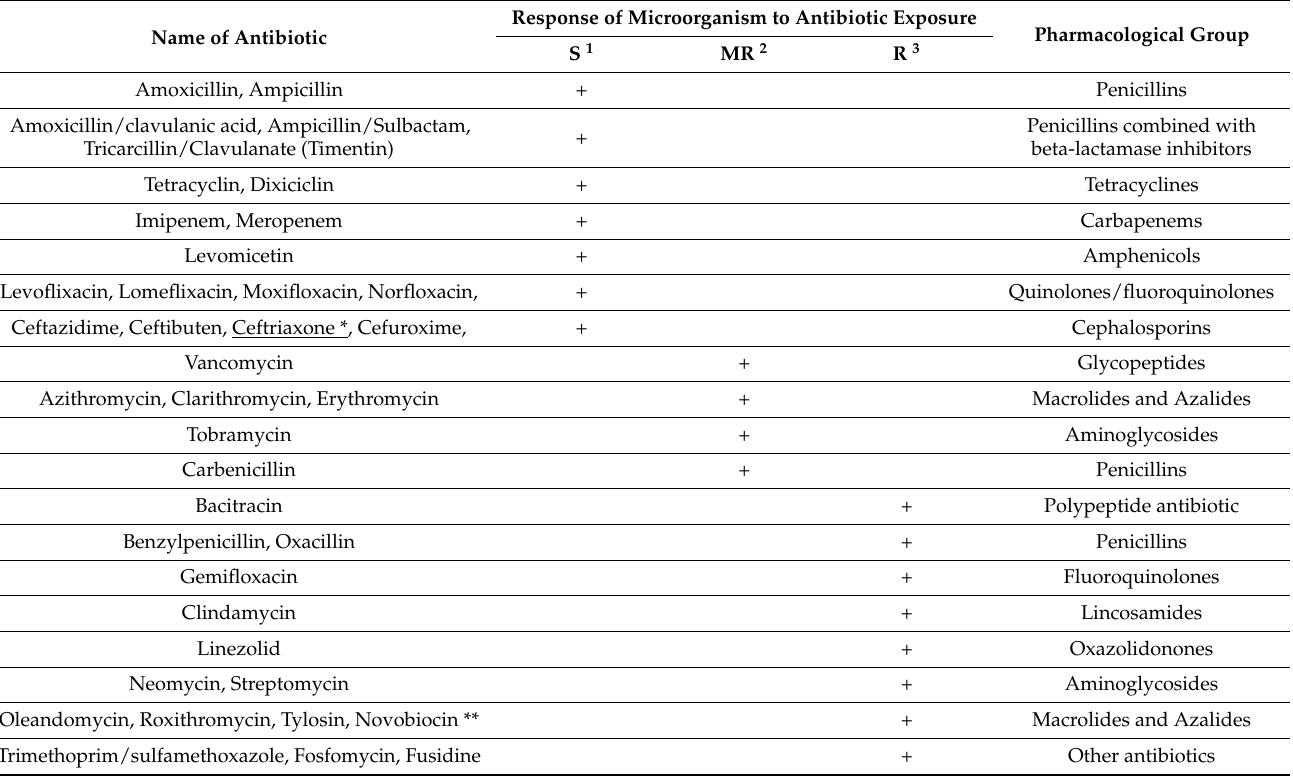
Table 1. Sensitivity of sample of E. coli M-17 to a basic set of